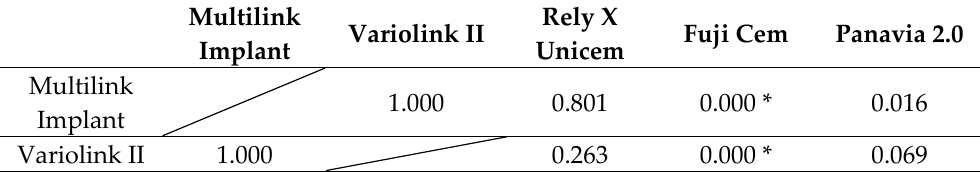
Table A6. Comparison of the different adhesives during the pull-off test: Celtra Duo.